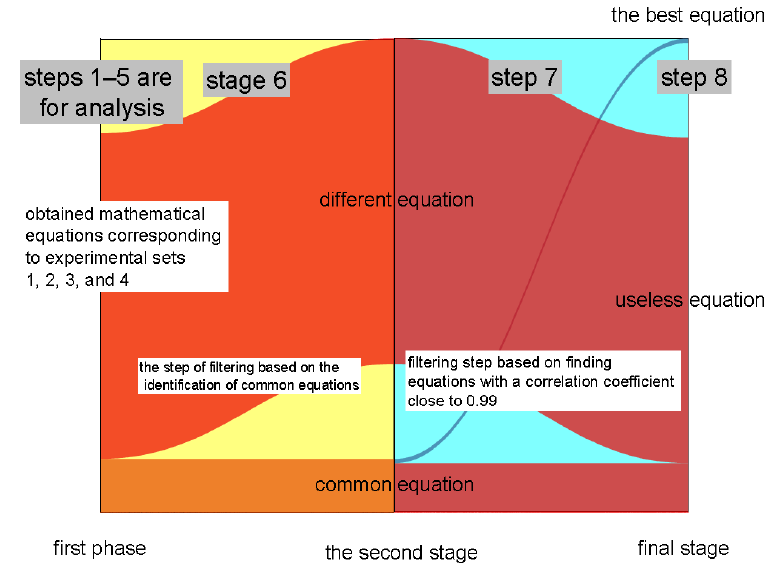
Figure 10. Summative graphical representation of the method used